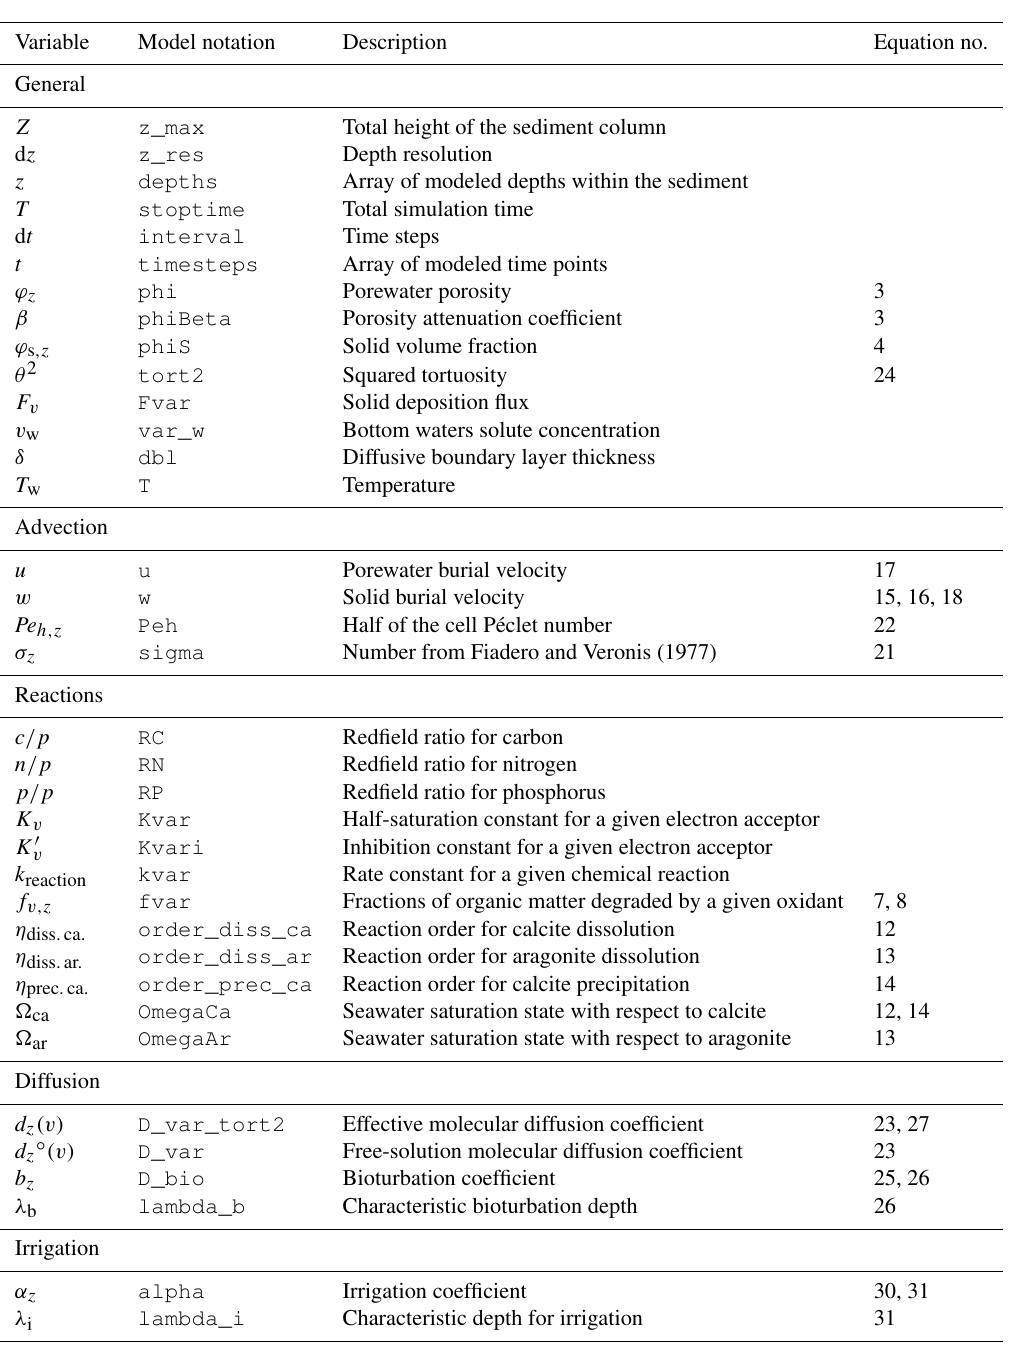
Table 1. Nomenclature of model parameters and variables.